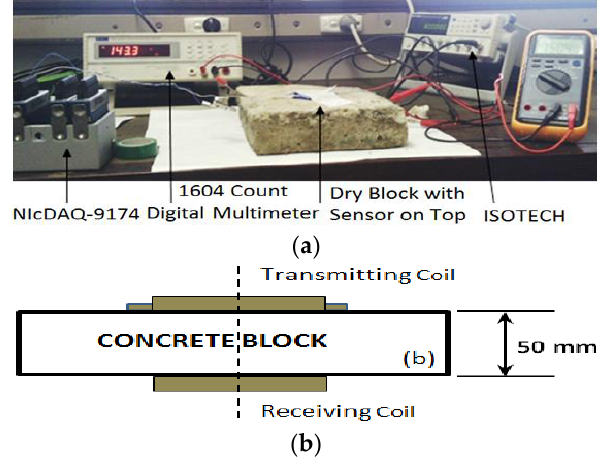
Figure 5. ( a ) MLC sensor test setup and (b) transmitter and receiver placed on opposite surfaces of block but lying on same centre line .